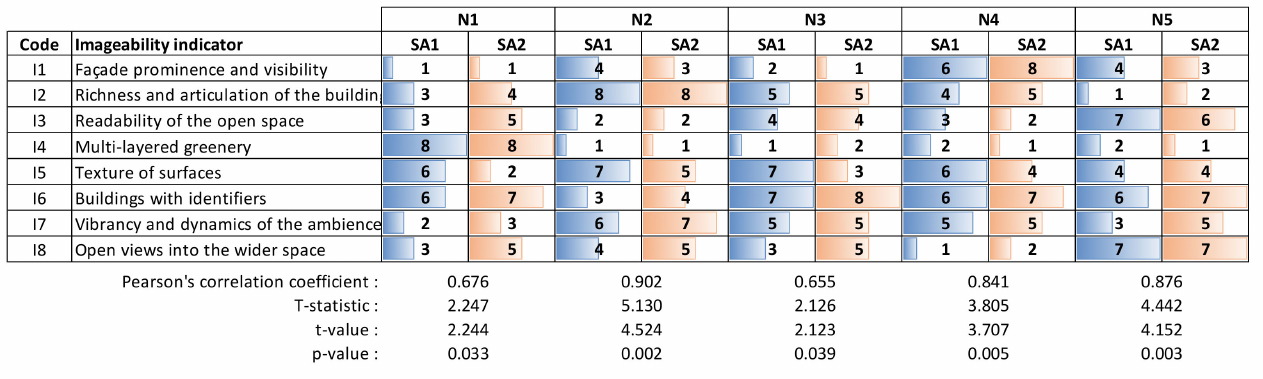
Figure 4. Ranks of responses on perception of imageability according to neighborhood and survey approach and results on testing the rank correlation coefficient’s significance.